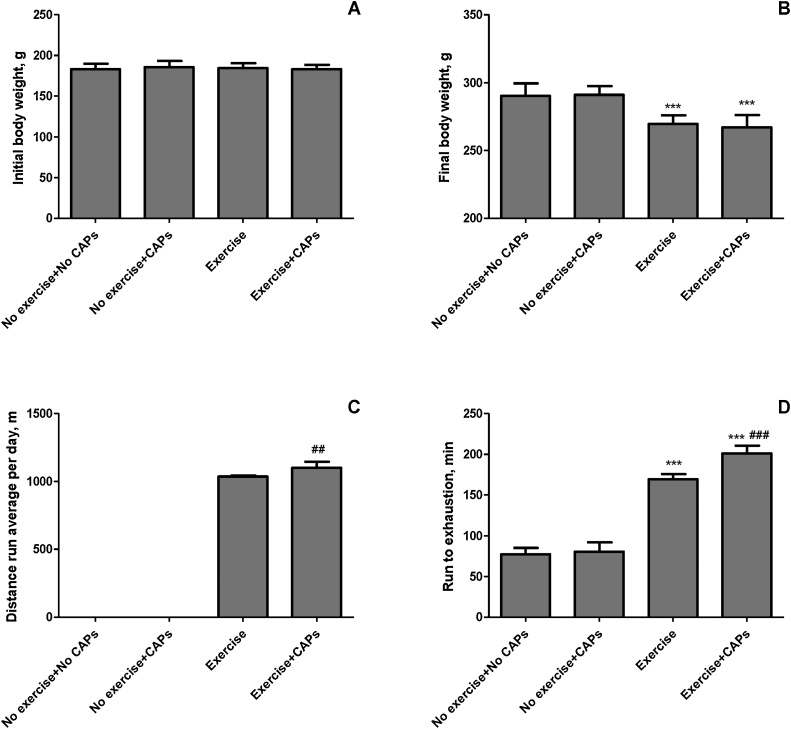
Effects of Capsaicinoids (CAPs) supplementation and regular exercise on body weight (initial BW Panel A and final BW Panel B), distance run average (Panel C) and exhaustion time (Panel D) in rats. Each bar represents the mean (n = 7) and standard error. *** p < 0.001 as compared with control group; ## p < 0.01, ### p < 0.001 as compared with exercise group.